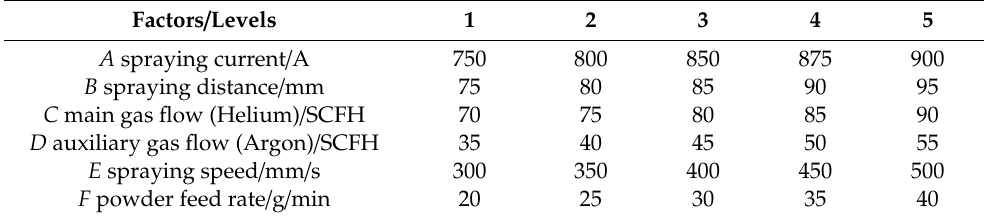
Table 3. Horizontal distribution table of orthogonal experimental factors of plasma spraying process